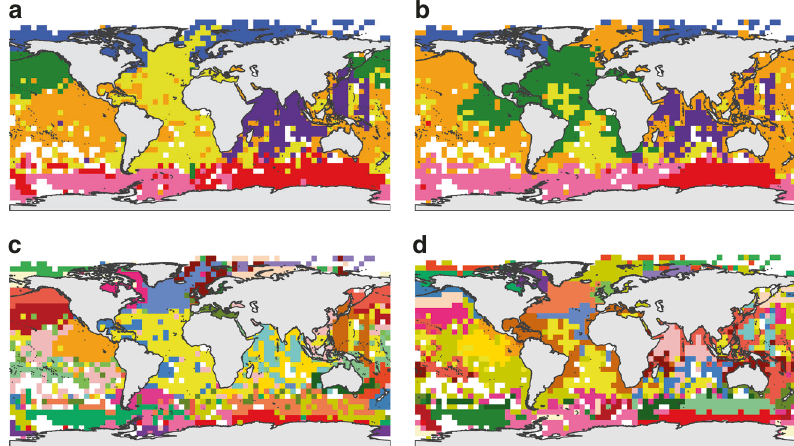
Fig. 2 Regionalisation of marine assemblages in cells with 5 species or more. Maps represent marine realms yielded by Simpson ( β sim : a , b ) or Jaccard ( β jac : c , d ) dissimilarity indices and Ward clustering, de fi ning 7 ( a , c ) or 30 ( b , d )